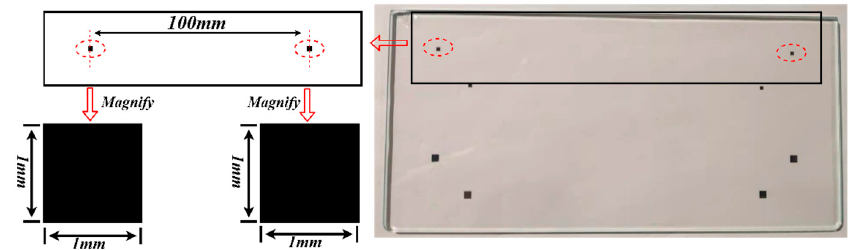
Figure 10. Schematic diagram of customized calibration board.